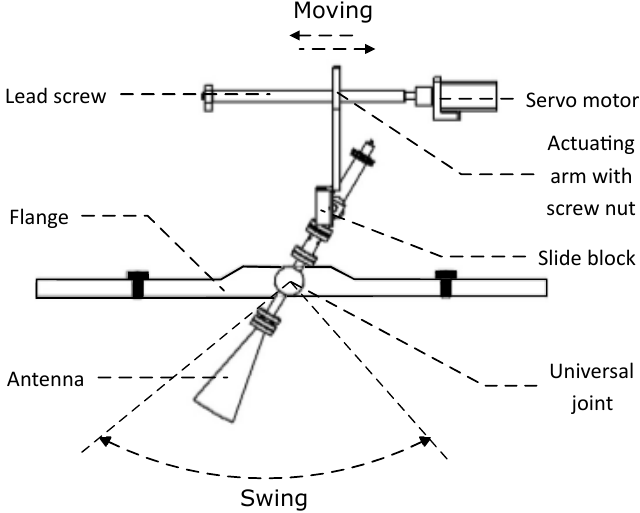
Figure 2. Mechanical servo system of